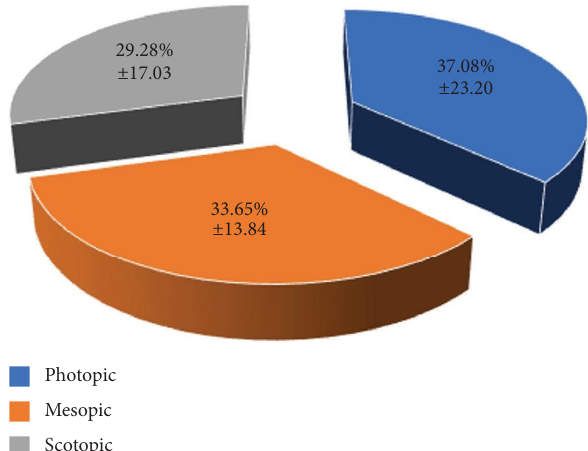
Figure 3: Mean percentage of the time dedicated to activities performed under photopic, mesopic, and scotopic conditions measured in the evaluated